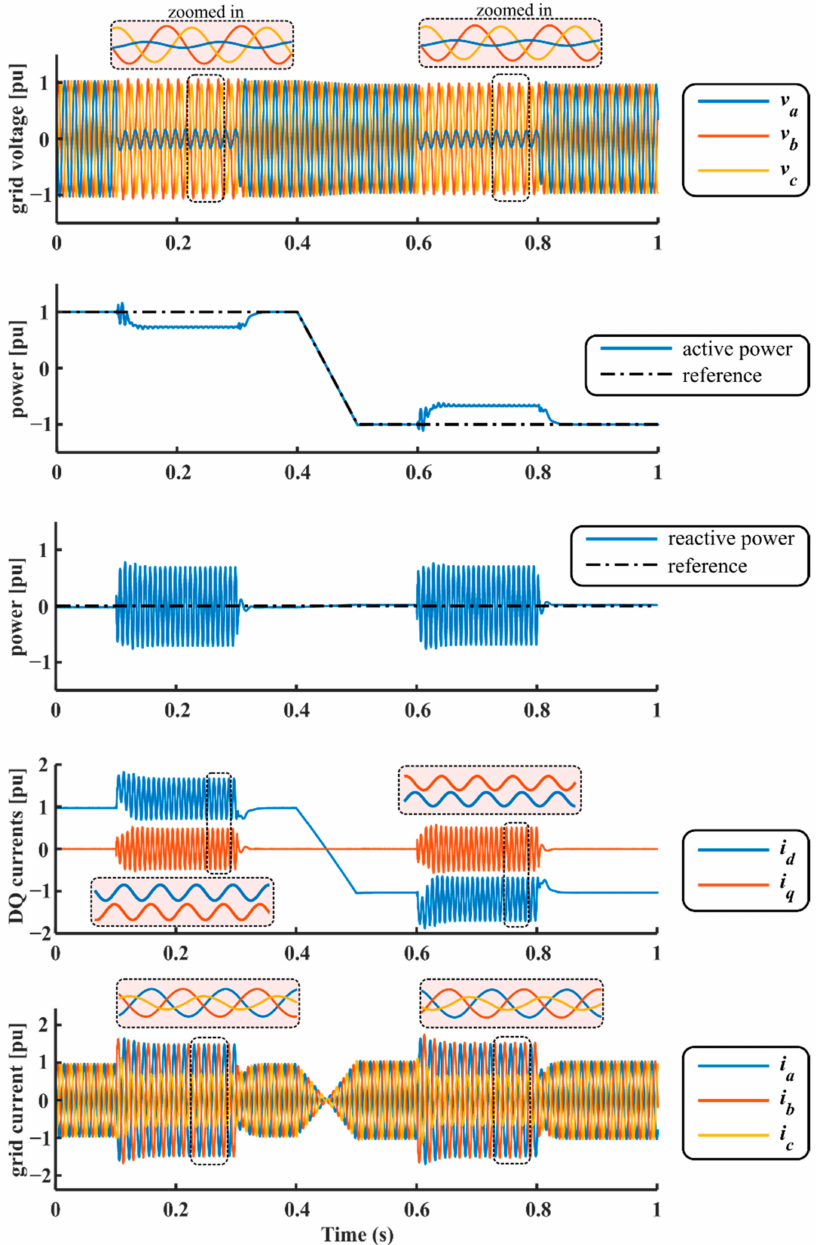
Figure 15. Dynamic performance of MMC with proposed feedforward control method under SLG